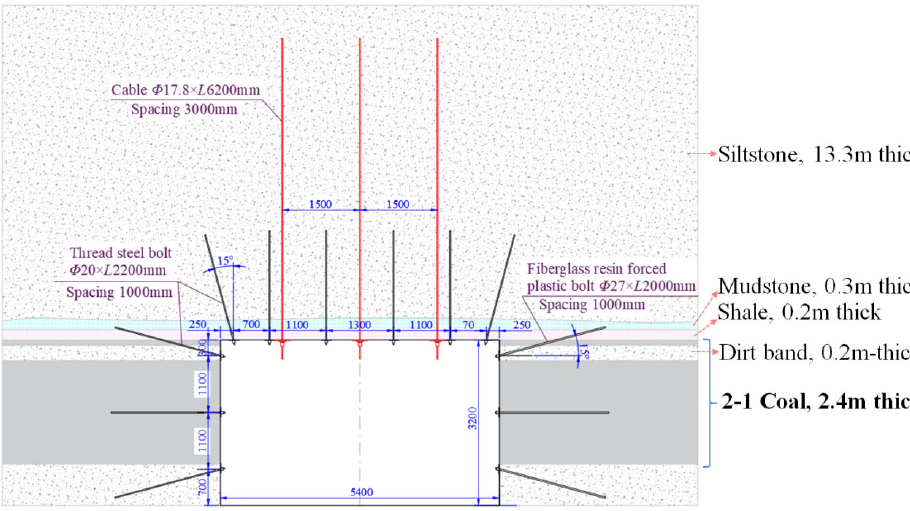
Figure 2. Original supporting scheme.